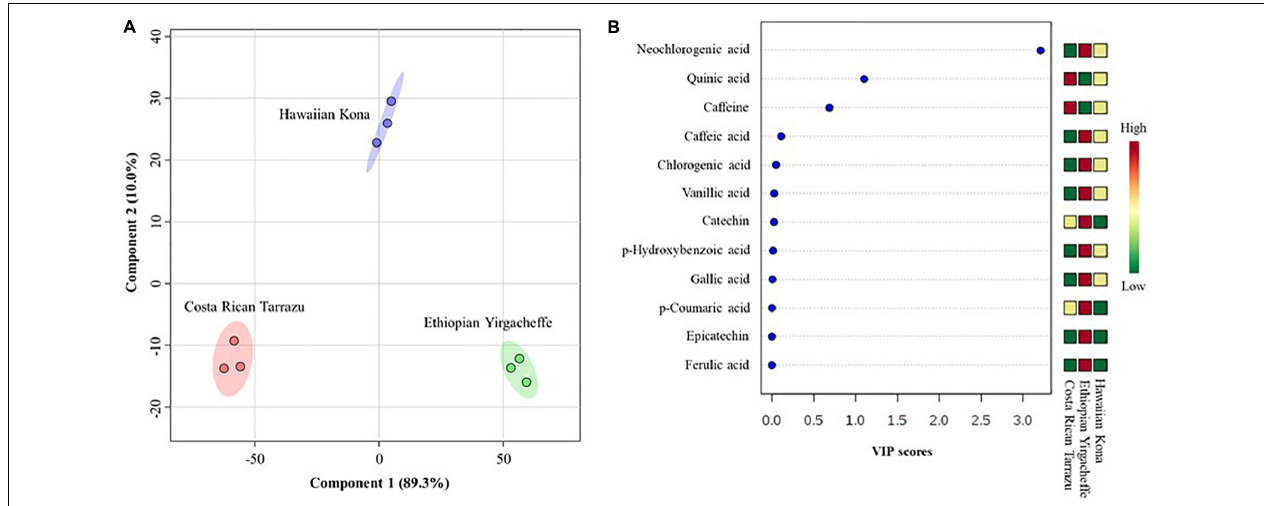
FIGURE 6 | Differences in anti-inflammatory profiles of spent coffee grounds from three coffee cultivars. (A) Partial least squares-discriminant analysis (PLS-DA), (B) Variable importance in projection (VIP). In the PLS-DA plot, circles with same colors represent replicates of metabolic profiles for each cultivar. The colored ellipses indicate 95% confidence regions of anti-inflammatory profiles for each cultivar. In the VIP score plot, the colored boxes on the right indicate the relative abundance of the corresponding anti-inflammatory compounds in each cultivar. Red represents higher relative abundance, whereas green and blue represent lower relative abundance in the VIP score